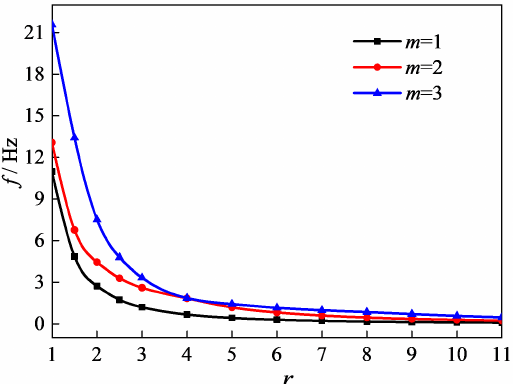
Figure 6: Relationship between natural frequencies snd aspect ratio with C-C-F-F boundary condition